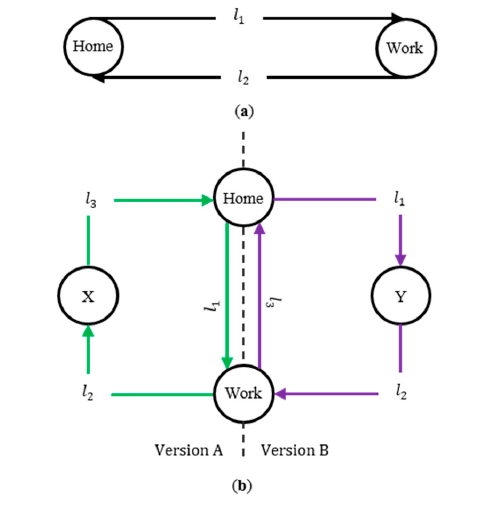
Figure 2. Two different types of EV owner’s daily trips: ( a ) Routine trip between home and workplace; ( b ) Non-routine trip among the home, workplace and intermediate places.